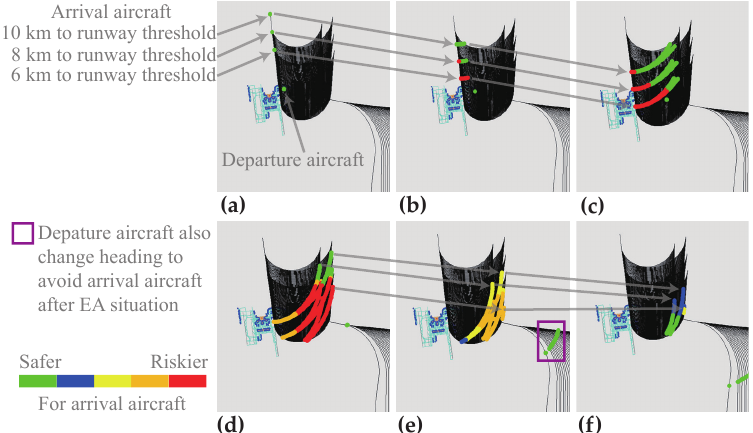
Figure 13. Schematic diagram of the southward operation of PKX under EA situation (the ADW separations are 0 km to 6/8/10 km respectively, aircraft type is A320). The screenshots in sub-graphs ( a – f ) illustrate the progression of simulation time. The gray arrows represent the relationship between arrival aircraft at various distances in successive simulation time frames. In the simulation process, EA situations might occur in every time frame for every arrival aircraft. Consequently, each sub-graph represents the EA situation of every arrival aircraft at a particular